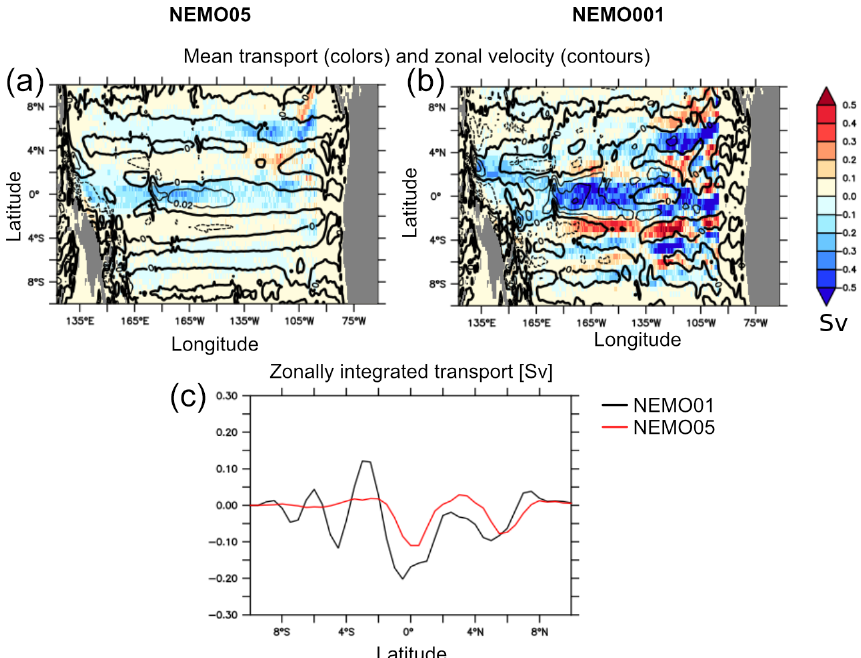
Figure 8. Mean transport (Sv) in (a) NEMO05 and (b) NEMO01 derived from the release of particles at 100 ◦ W, 10 ◦ N–10 ◦ S, 500–1500m (backward integration). The mean zonal velocity (ms − 1 ) is represented as a contour. (c) Zonally integrated transport (Sv) derived from the release of particles at 100 ◦ W, 10 ◦ N–10 ◦ S, 500–1500m in NEMO05 (red) and NEMO01 (black). Negative values correspond to westward transport, while positive values correspond to eastward